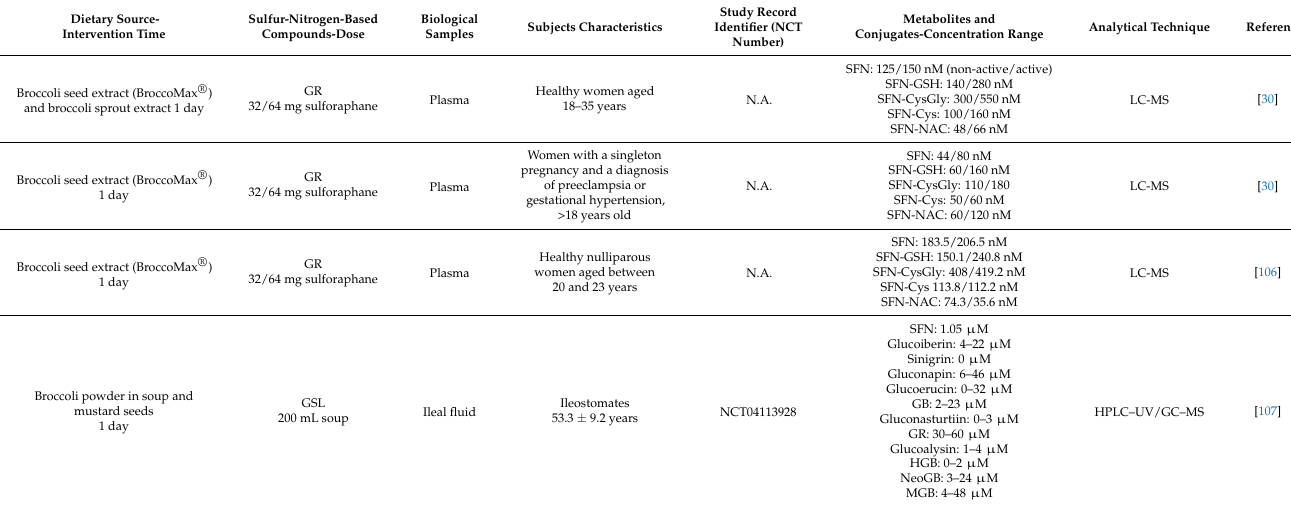
Table 4. Seeds, Extracts, or formulas enriched in